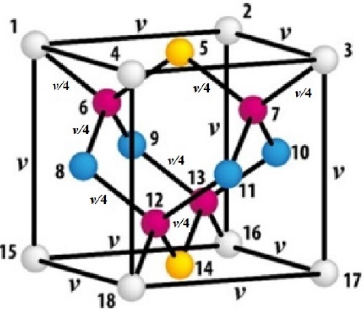
Figure 6. Three-dimensional graph model of synthetized diamond.